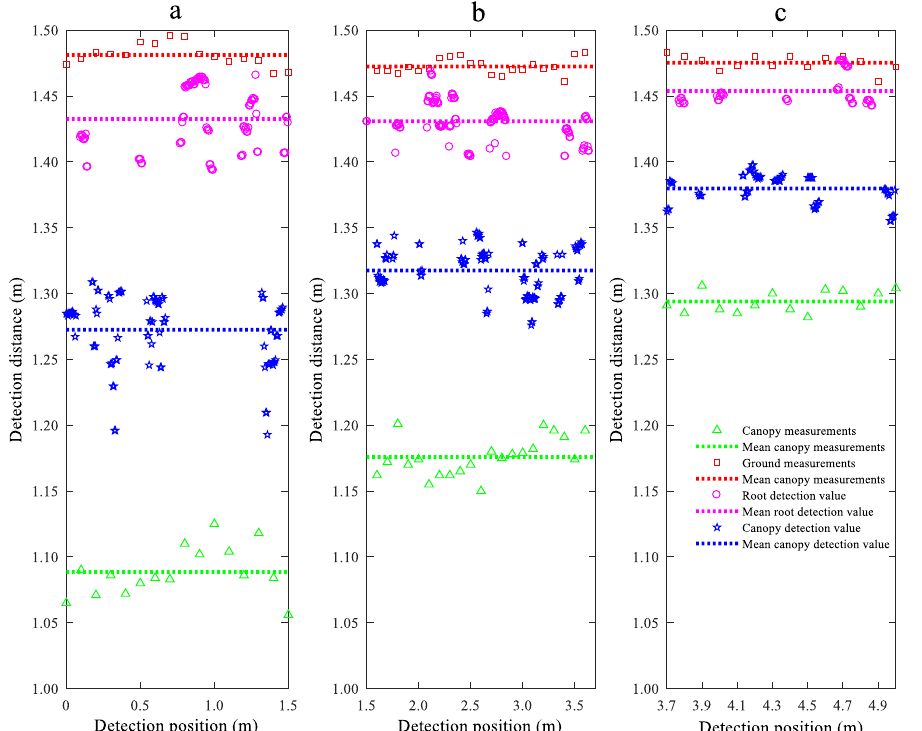
Figure 11. Detection results of LiDAR sensor for different WS heights. To analyse the effects of H WS on the detection performance of the LiDAR sensor for the WS roots and canopy, the mean errors of the distances detected by the LiDAR sensor from the WS roots and canopy in areas a, b, and c were statistically analysed, and the results are shown in Figure 12. As demonstrated in Figure 12, for each area, the mean error of the distances detected by the LiDAR sensor from the WS roots is lower than that of the distances detected by the LiDAR sensor from the WS canopy. As H WS decreases, the mean detection errors of the LiDAR sensor for both the WS roots and canopy in each area gradually decrease. The maximum and minimum detection errors of the LiDAR sensor for the WS roots are 3.08% and 1.40%, respectively. There are no significant changes in the detection error of the LiDAR sensor between areas a and b. However, the detection error of the LiDAR sensor for area c is notably lower than those for areas a and b. This is because in areas a and b, the WS canopy is relatively high, and the litter layer at the WS roots had been relatively insignificantly damaged during the harvesting process. In contrast, in area c, the litter layer had been relatively significantly damaged during the harvesting process, so